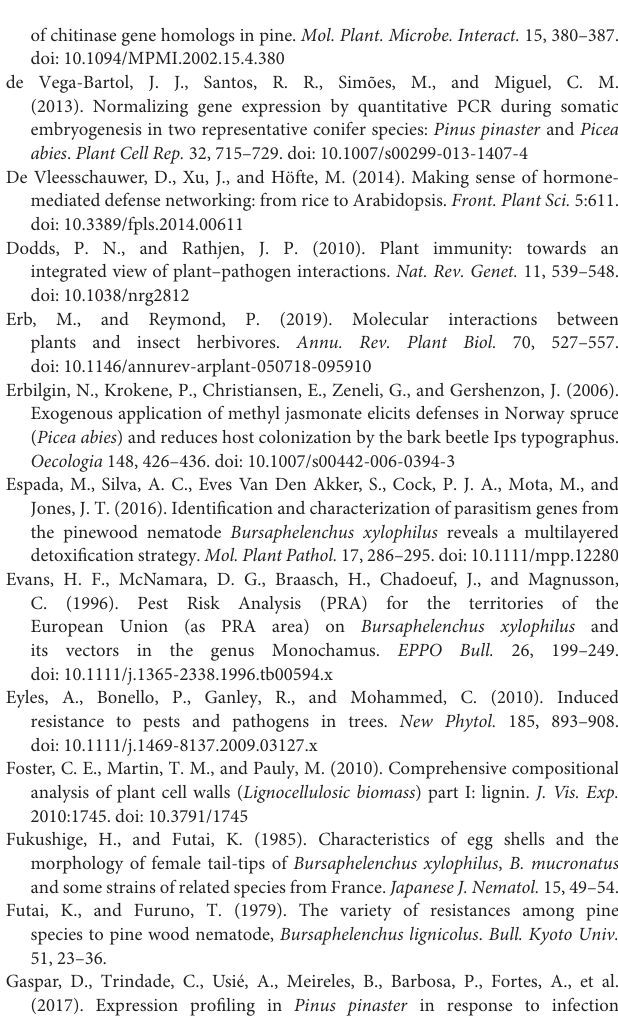
Supplementary Table 8 | Complete list of genes annotated with DRAGO 2 tool. Supplementary Table 9 | Genes used for calculating average log2(fold change) expression levels for Figures 5 , 6 . Data Sheet 1 | Fasta file with de novo assembled Pinus pinaster